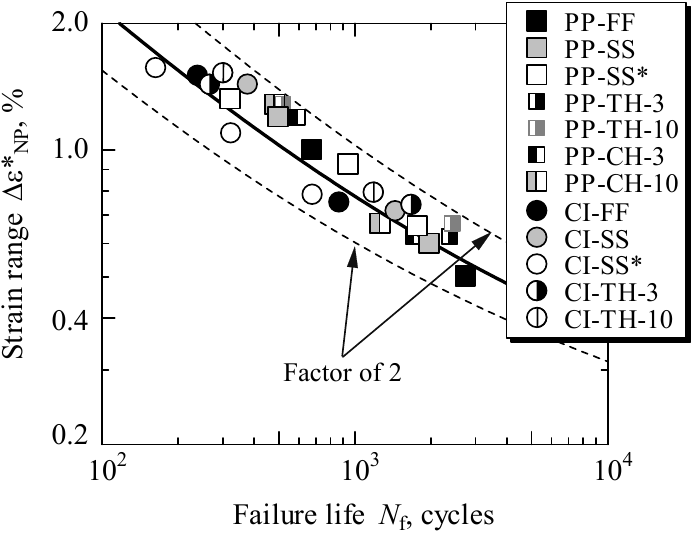
Figure 8: Correlation of N f by modified non-proportional strain